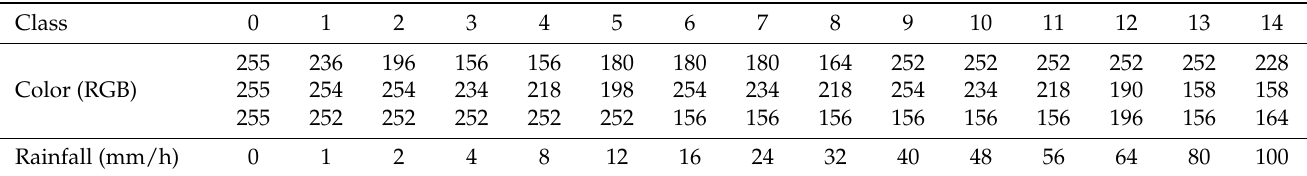
Table 1. Lookup table between the RGB colors of the radar image representation, precipitation intensity, and the numerical value assigned to the